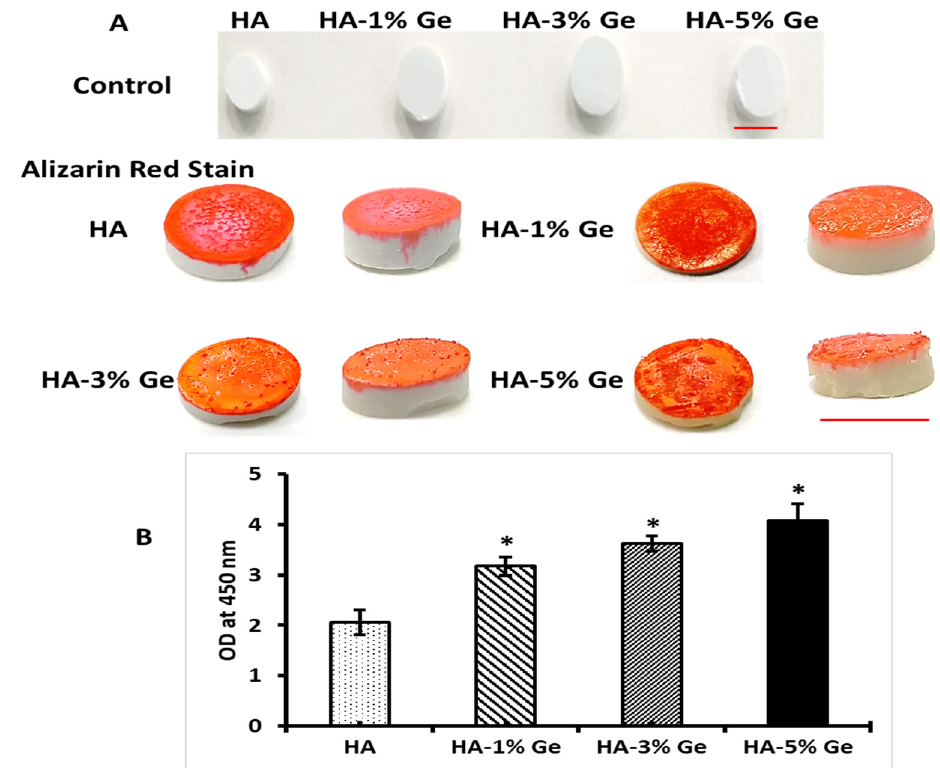
Figure 8. In vitro bioactivity of HA-Ge biomaterials after SBF treatment for 28 days with Alizarin red stain. ( A )—samples with Alizarin red stain, Scale bar —1 cm, and ( B )—UV absorption of Alizarin red stain on samples at 450 nm ( B ). HA-control, HA-1%Ge-HA with 1% germanium, HA-3%Ge-HA with 3% germanium and HA-5%Ge-HA with 5% germanium. The UV absorption of control (1st row in image ( A )) was below the measurable range. The bioactivity of HA was significantly improved by Ge. * denotes statistical significance p < 0.05 vs. HA.